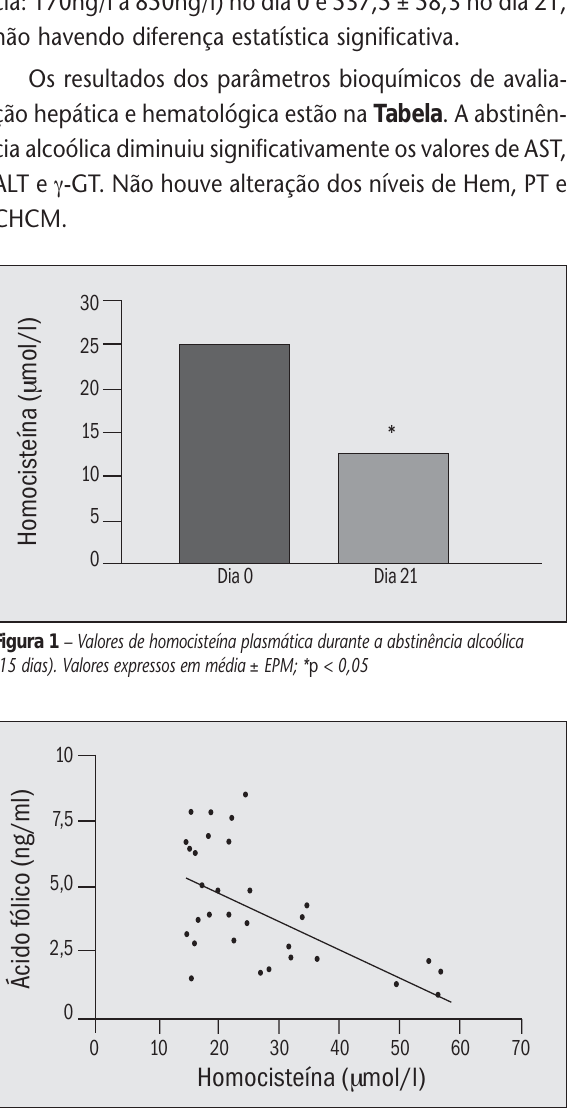
referência: 4ng/l-20ng/l), sendo que 48,3% dos pacien- tes tinham valores abaixo dos de referência.